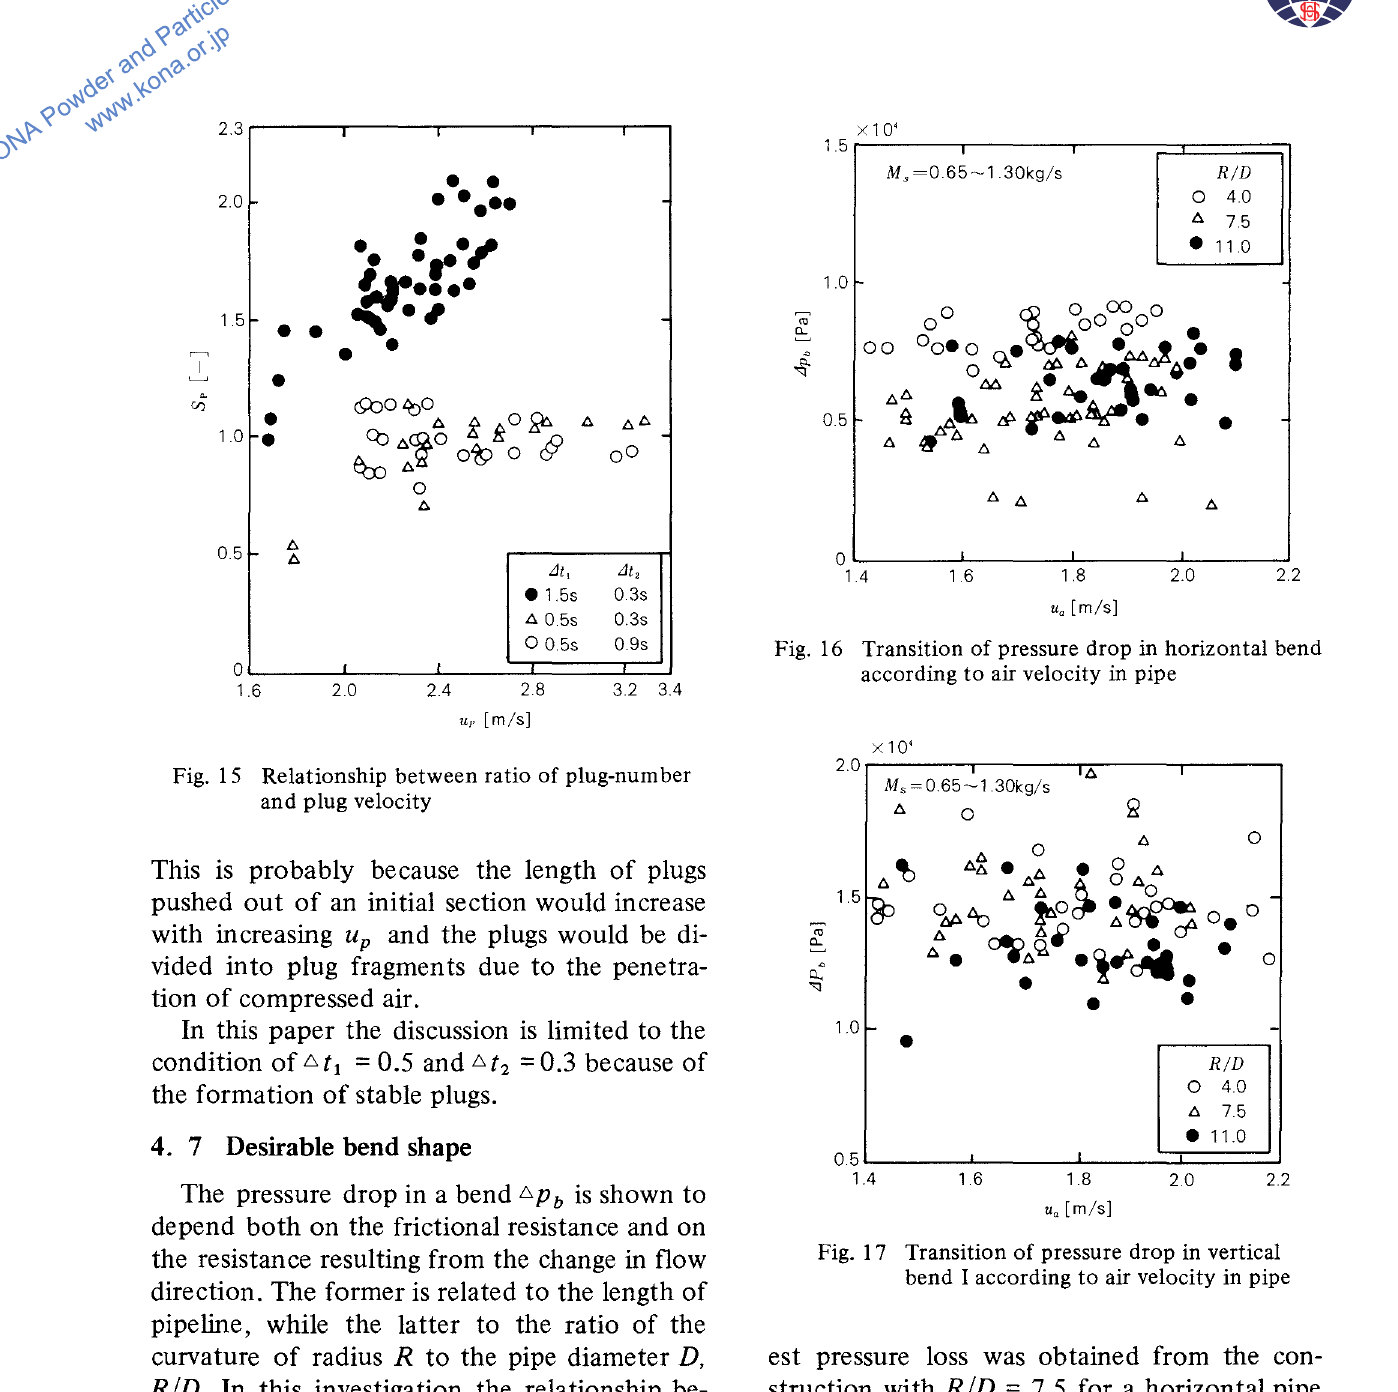
Fig. 1 7 Transition of pressure drop in vertical bend I according to air velocity in pipe est pressure loss was obtained from the con struction with R/D = 7.5 for a horizontal pipe as shown in Fig.16 and R/D = 11.0 for a verti cal bend I as shown in Fig.17. In the latter case, the resistance was large because of the change in the flow direction from horizontal to upward, so that a larger radius of curvature could possibly provide a smoother flow. For vertical bend II, on the other hand, remarkable correlations could not be observed as shown in Fig. 18. It might be because the pressure drop in such a case was more susceptible to pressure fluctuation than to changes in the radius of